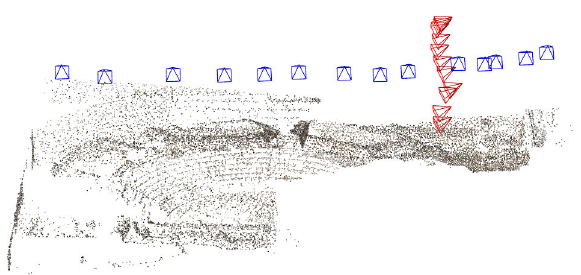
Figure 3. The UAV dataset Ventimiglia Theatre Oblique with two orthogonal image strips (blue, red) with convergent orientation. Only the proposed HP method could correctly orient all images.